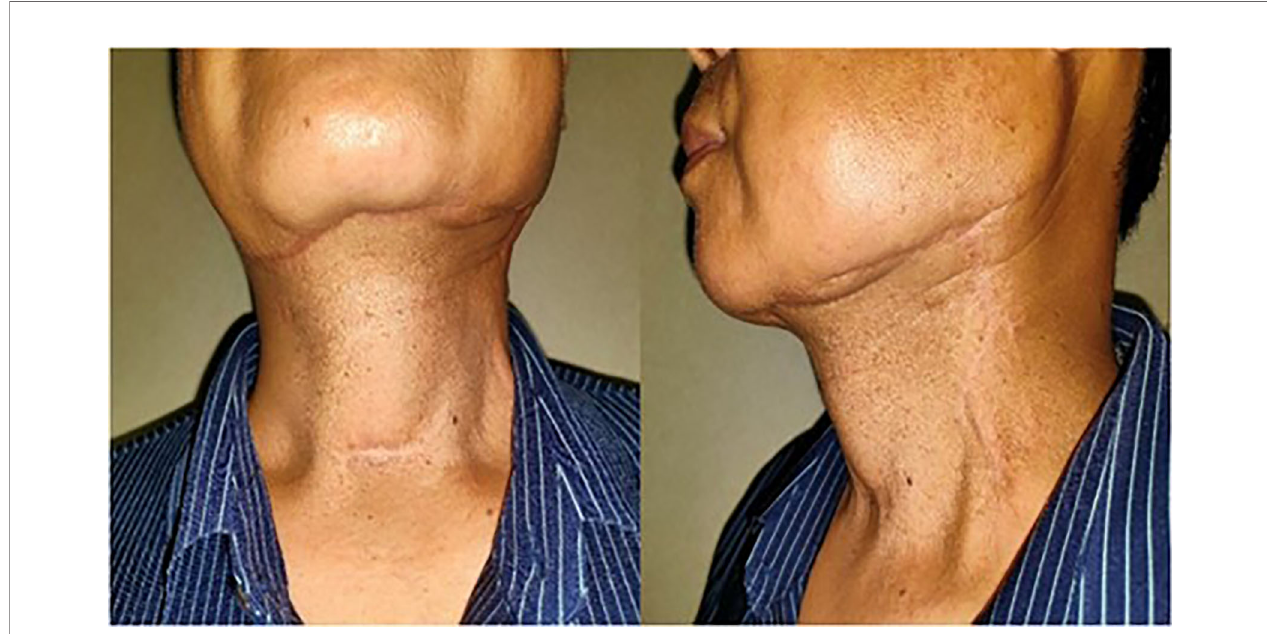
FIGURE 3 | Reexamination 2 years after surgery. There were no obvious facial